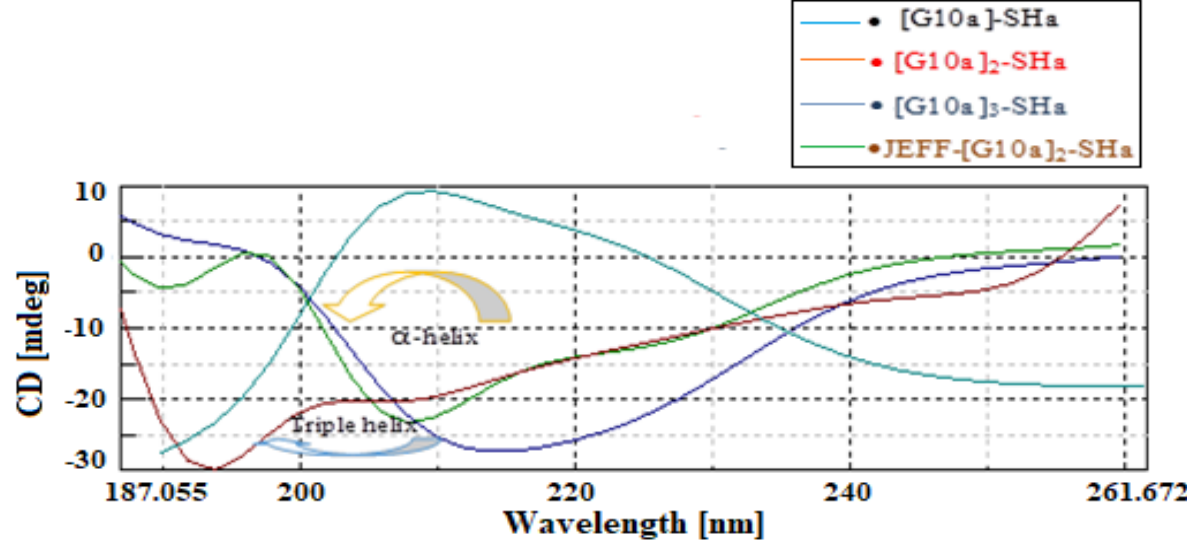
Figure 2. CD spectra of dendrimer peptides in 20 mM SDS solution.